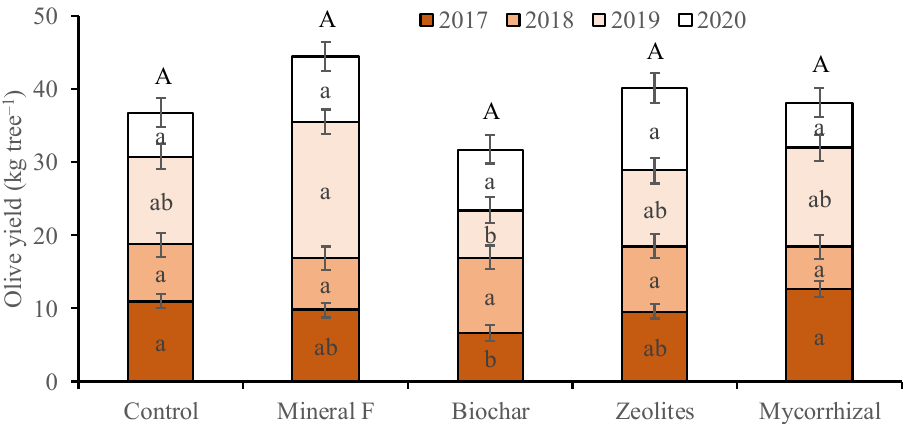
Figure 2. Annual olive yield and accumulated total. Separated by year (lowercase letters) and total (uppercase letters), means followed by the same letter were not significantly different by Tukey HSD test ( α = 0.05). Vertical bars are the standard errors. Pruning wood followed a similar hierarchy between treatments to that observed with olive yield (Figure 3). However, in this case, total pruning wood varied significantly be- tween treatments. The highest average value was found in the mineral fertilizer treatment (21.5 kg tree ‒ 1 ), whereas the lowest one was in the control treatment (17.5 kg tree –1 ). Sepa- rated by years, significant differences between treatments were found in 2017 and 2020, with the highest average values to be found respectively in the zeolites (5.0 kg tree –1 ) and in mineral fertilizer (6.8 kg tree –1 ) treatments, respectively.